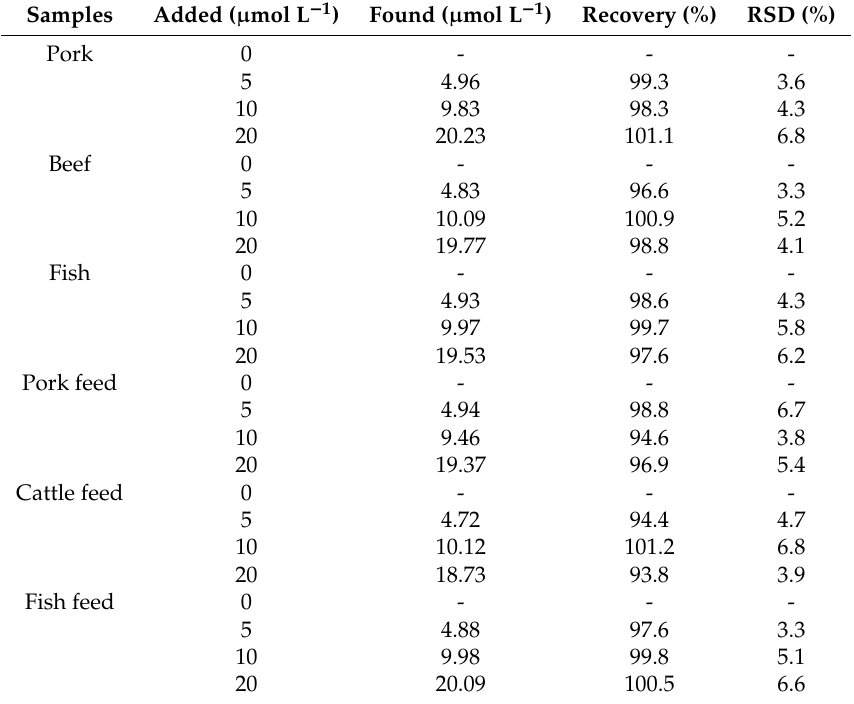
Table 1. Spiked recovery results for QCA detection in real samples.